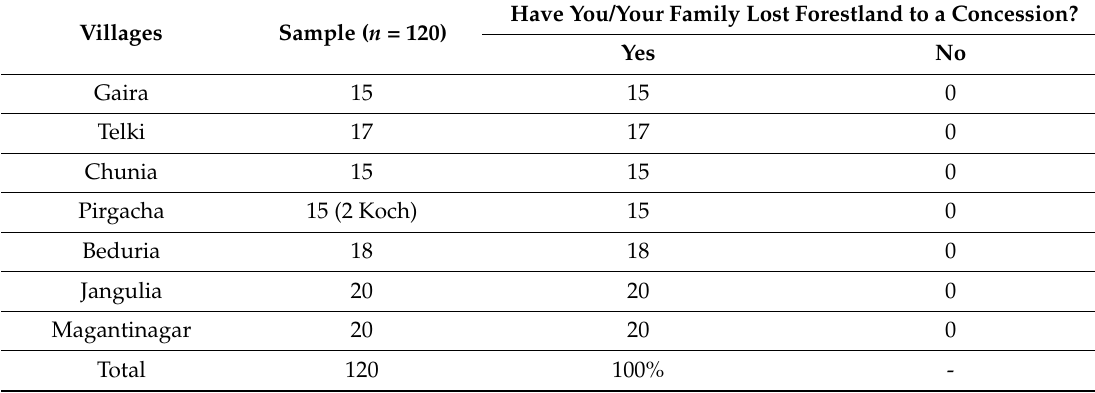
Table 4. Ethnic minority families facing land concession and losses of